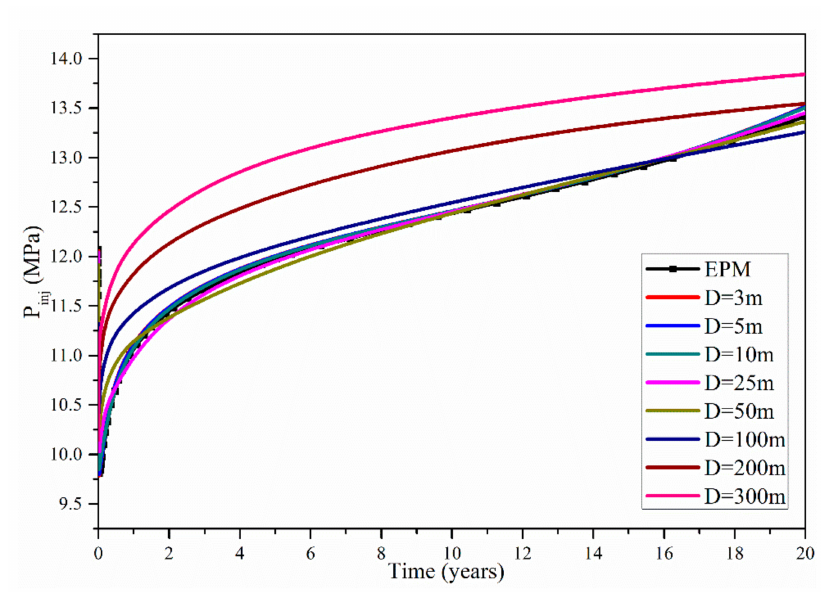
Figure 6. Evolution of the injection pressure of the EPM method and the MINC method.